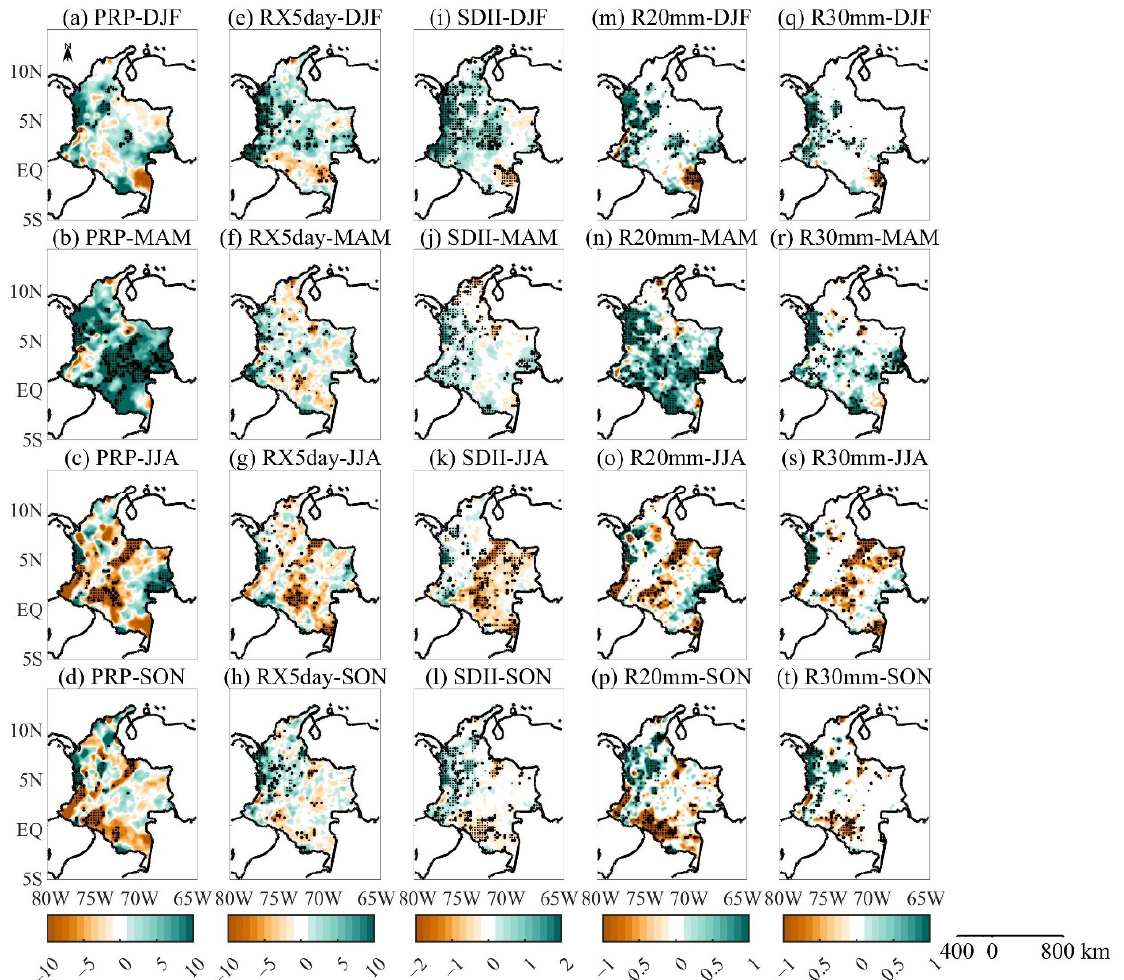
Figure 9. Trends of seasonal time series of extreme precipitation indices during the 1981–2018 period: ( a )–( d ) rainfall (PRP), ( e )–( h ) Max 5-day precipitation amount (RX5day), ( i )–( l ) Simple daily intensity index (SDII), ( m )–( p ) Number of days with precipitations above R20mm (R20mm), and ( q )–( t ) Number of days with precipitations above R30mm (R30mm) used the time series of extreme climate indices during December–February (DJF) ( first row ), March–May (MAM) ( second row ), June–August (JJA) ( third row ), and September–November (SON) [( last row ). Green and brown areas represent the positive and negative trends, respectively. Filled (empty) dots are significant trends at the 95% significance level.